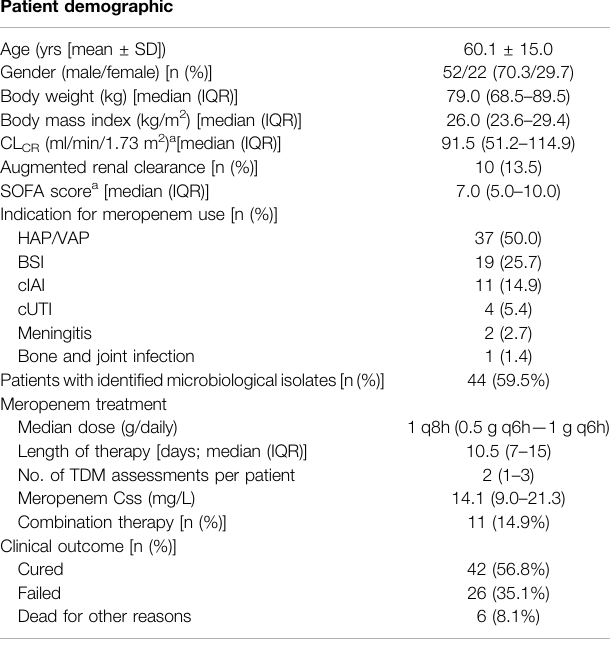
TABLE 1 | Population characteristics. Patient demographic